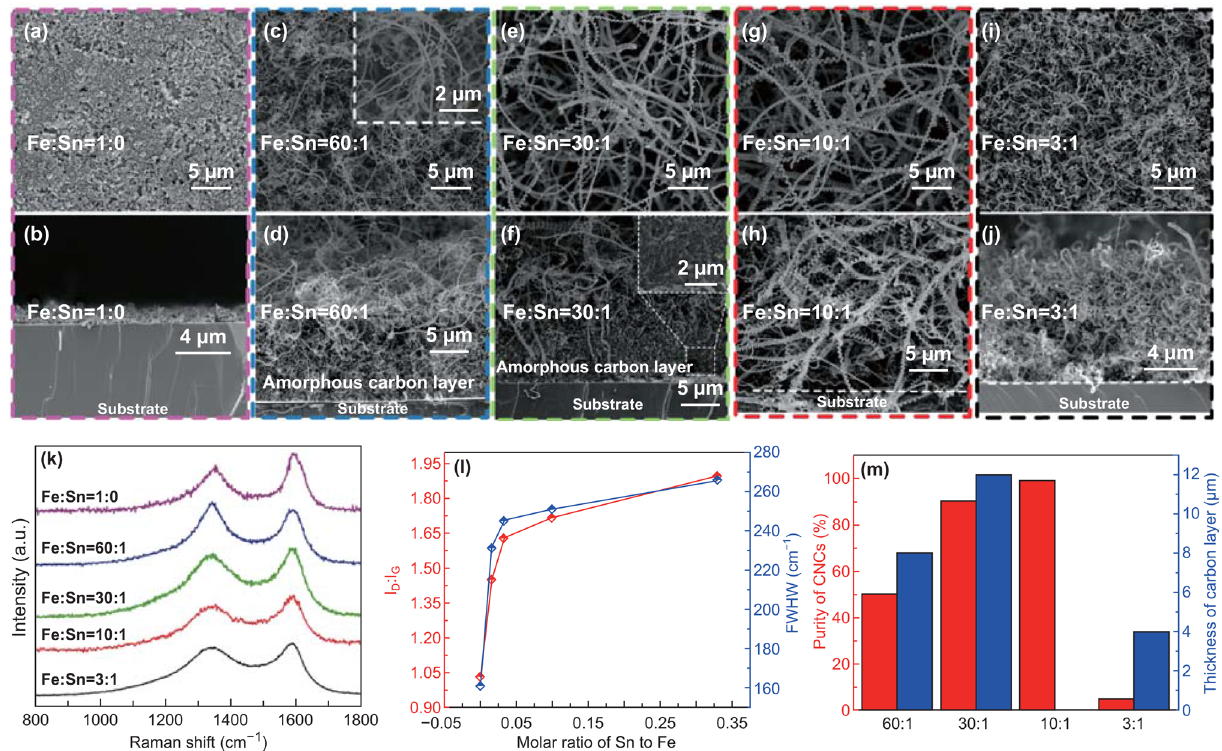
Fig. 1 Top-view and cross-sectional SEM images of the carbon deposits prepared by the catalysts with different Fe/Sn molar ratios of a, b 1:0, c, d 60:1, e, f 30:1, g, h 10:1, and i, j 3:1. k Raman spectra and l the respective I D / I G and FWHW values for the carbon deposits; m the thickness of carbon layer and purity of CNCs synthesized at different Fe/Sn molar